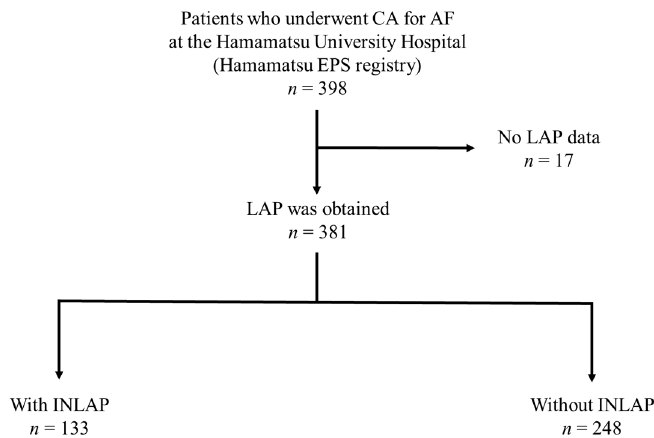
Figure 2. Schematic diagram for patient selection in the study. Abbreviations: CA, catheter abla- tion; AF, atrial fibrillation; LAP, left atrium pressure; INLAP, inspiration-induced negative left atrium pressure.